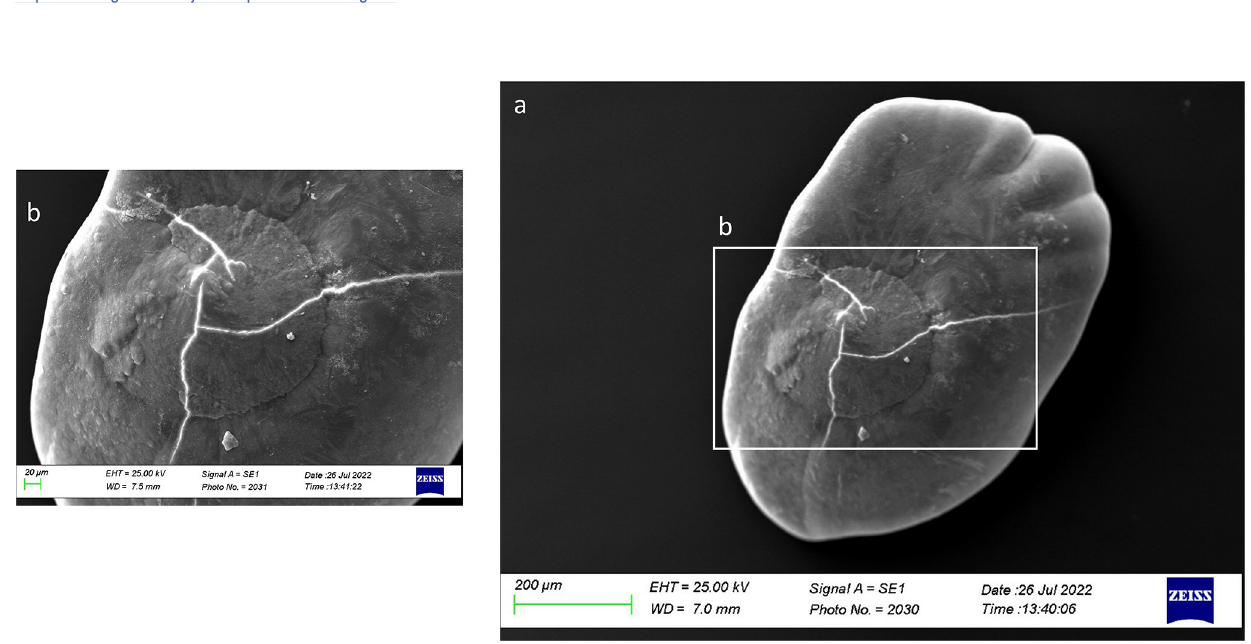
Fig 15. SEM images of a right sagitta external surface belonging to size Class IV (a) with details of the external textural organization of the core zone (b).